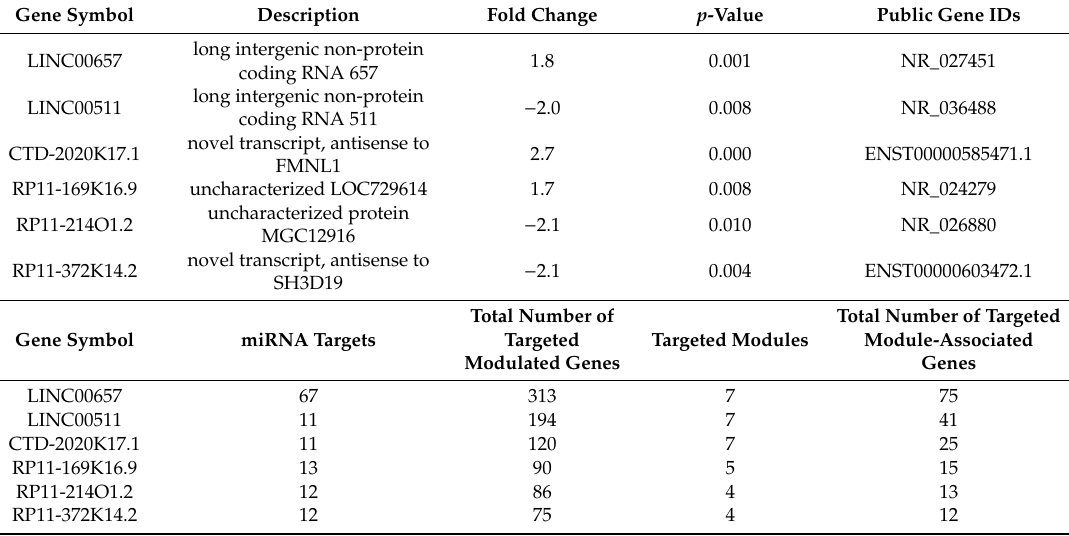
Table 2. Selected long non-coding RNAs modulated in pSjS patients versus healthy subjects. Gene